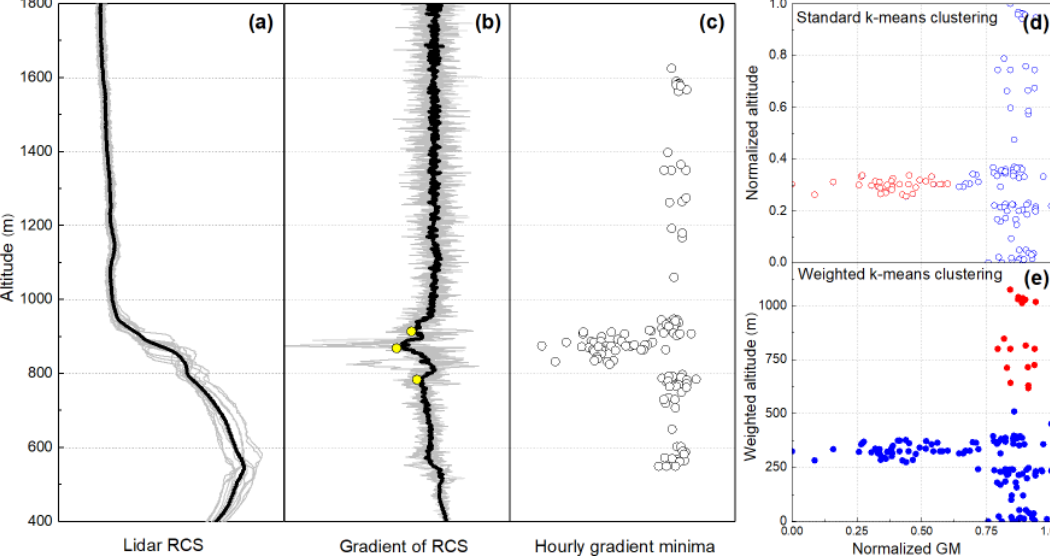
Figure 2. The theoretical schematic of the weighted k -means clustering. (a) The real profile of a lidar RCS (light grey line) and the hour- averaged RCS (black line). (b) The gradient of RCS (light grey line), the hour-averaged gradient RCS (black line), and the three minima in the profile (yellow points). (c) The distribution of the gradient minima within an hour. (d, e) The results obtained by standard k -means and weighted k -means clustering, where two clusters are differentiated, as shown by hollow and solid red and blue points,